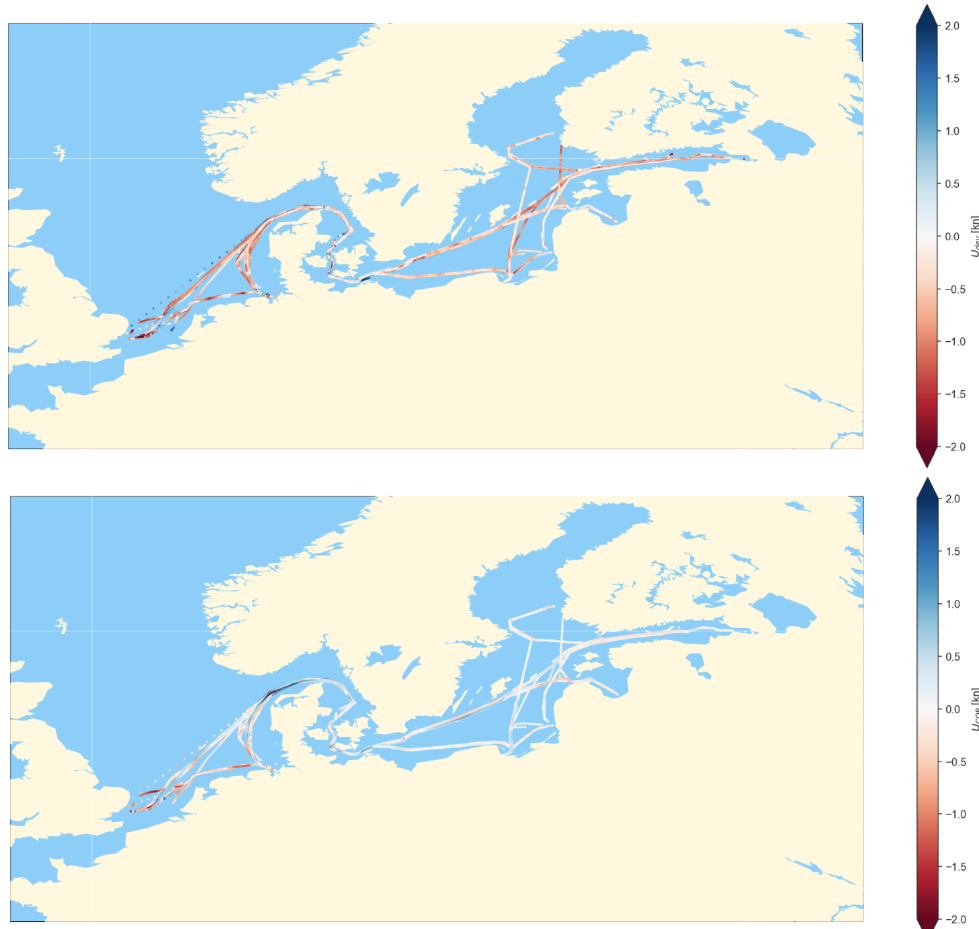
Figure 18. Full journey of a C.27 class ship from 04/12/2018 to 22/02/2020. Upper map shows a density plot of U dev where on the bottom map, the same for U COP